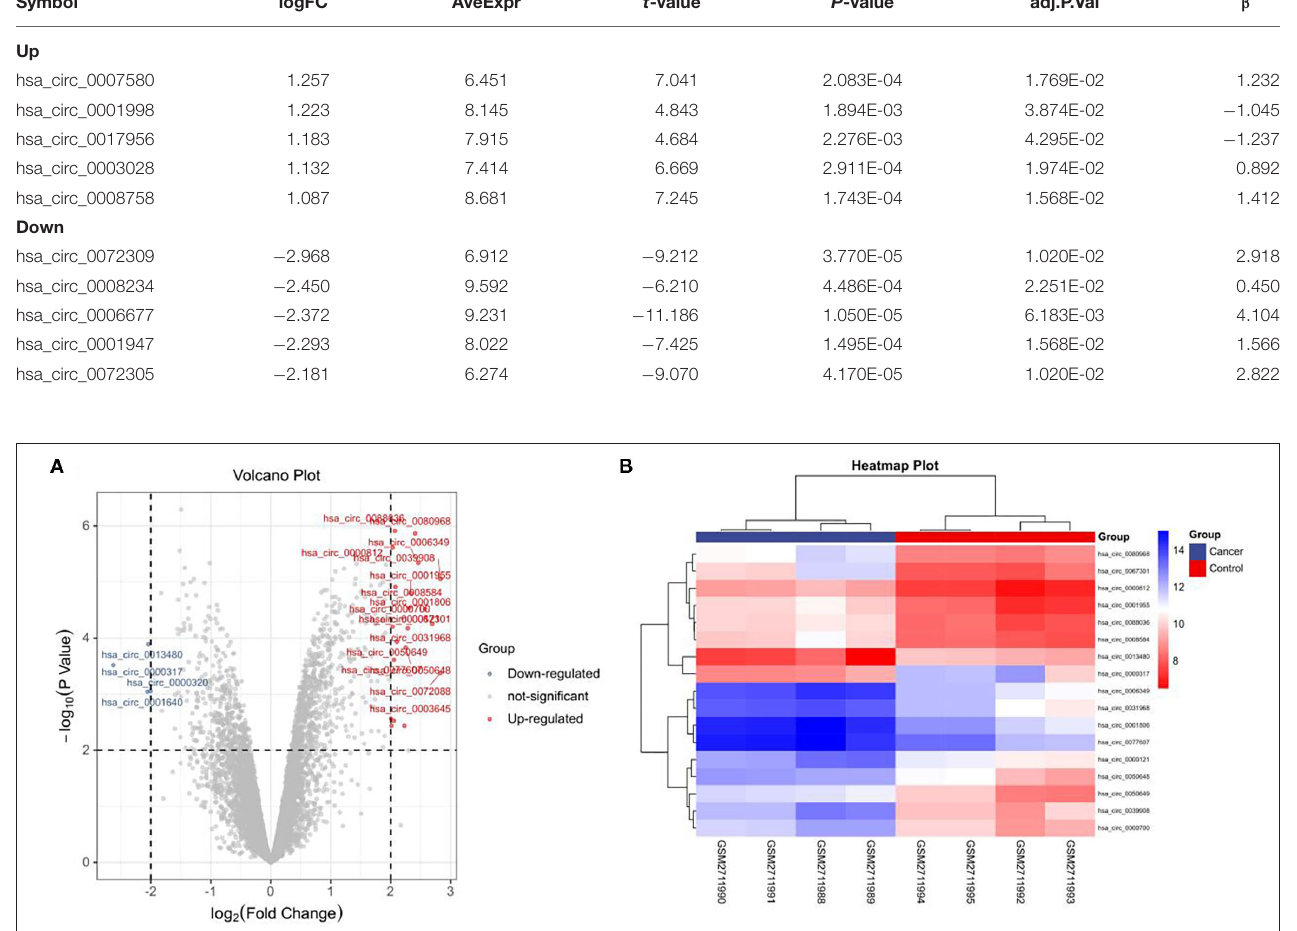
TABLE 2 | The top five up- down-regulated circRNAs in the GSE112214 microarray. Symbol